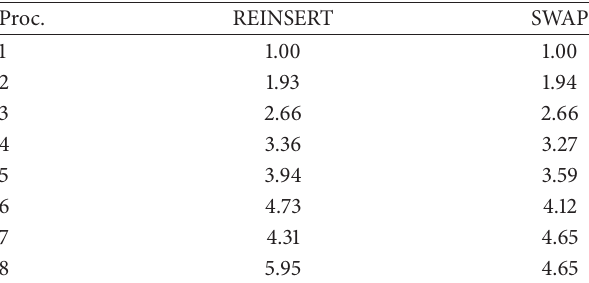
Table 7: Speed-up: 𝑁 (𝐼) with random start.